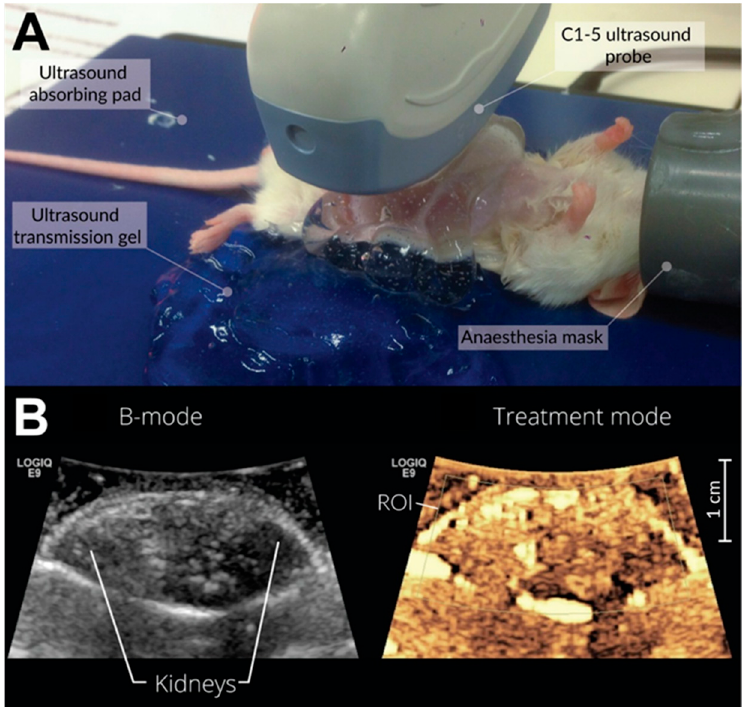
Figure 3. Photograph of treatment configuration and a representative ultrasound image. Mice were placed in a dorsal recumbent position on a heated, ultrasound transmission gel-covered ultrasound absorption pad, and the C1-5 curvilinear probe was placed on the abdomen to target both kidneys ( A ). Exact alignment of the kidneys was achieved via the ultrasound image where the kidneys could be clearly delineated ( B, left ). The treatment mode ( B, right ) is a contrast mode image, captured prior to microbubble injection, that shows the locations of nonlinear echoes. The bright areas seen in this image are due to high-amplitude echoes that also contain nonlinear acoustic contents. The ROI indicates the focal area where long treatment pulses are targeted and where treatment is ex- pected.